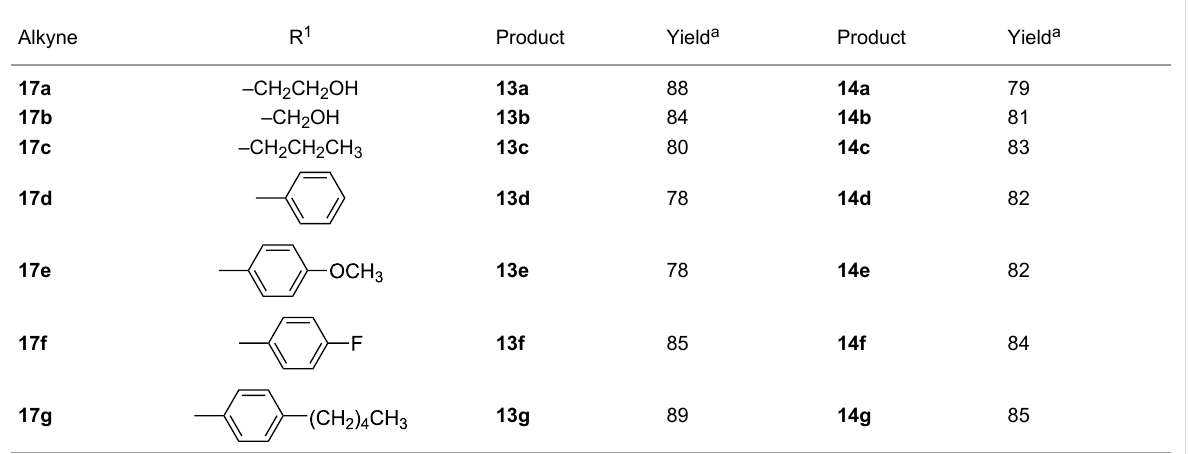
Table 1: C-5’-Triazolyl-2’-oxo-3’-aza-4’a-carbanucleosides 13a–g and 14a–g produced via click chemistry.